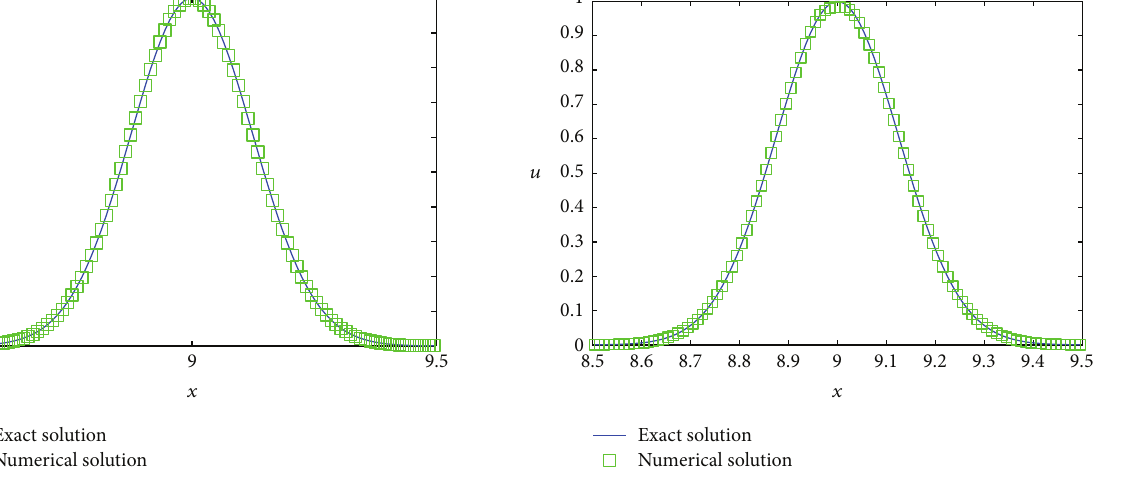
Figure 3: SHA method with TVD (27a) applied to linear advection equation with a continuous initial value; numerical (symbols) and exact (line) solutions are compared at 𝑡 = 9 units.